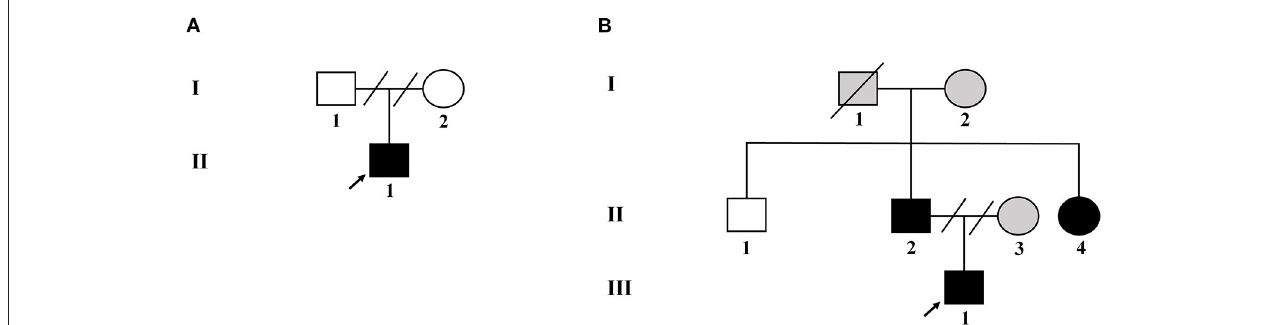
FIGURE 1 | Pedigree of the two unrelated Chinese families with NF-1. (A) Pedigree of family 1. (B) Pedigree of family 2. Black filled symbols represent affected subjects. Arrowhead indicates the probands. Empty symbols depict unaffected members. Gray filled symbols indicate the subjects without genetic testing. Connecting lines combined with slashes indicate the state of divorce. Diagonal line means decreased